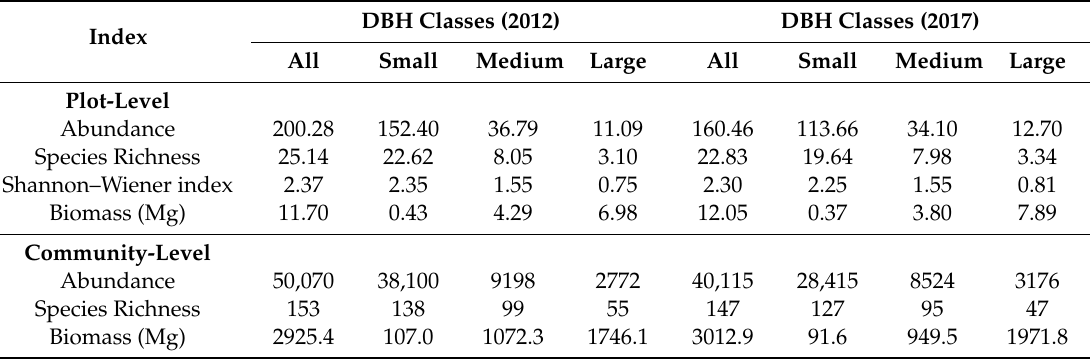
Table 2. Community characteristics of di ff erent diameter at breast height (DBH) classes during forest